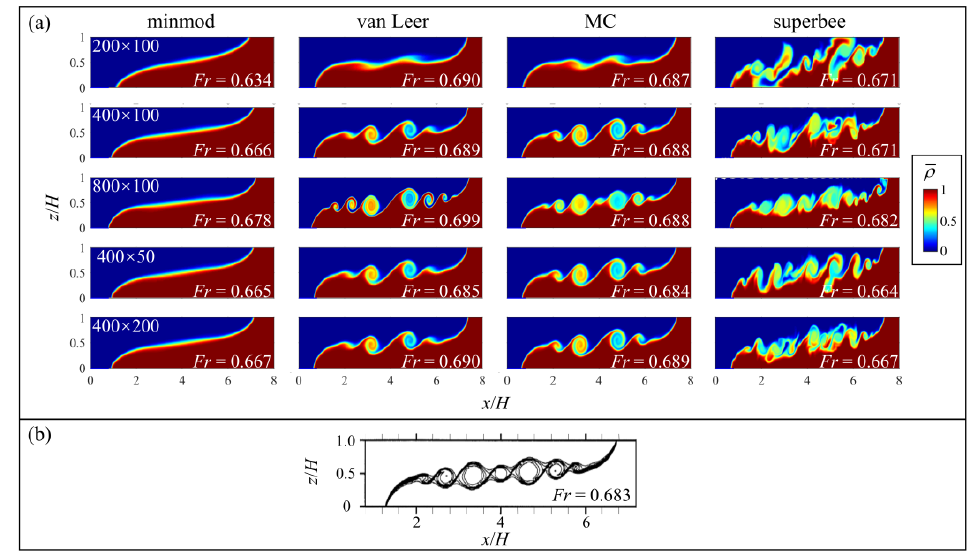
Figure 15. ( a ) Comparison of the simulated density ( ρ = ρ − ρ 1 / ρ 2 − ρ 1 ) distributions for constant viscosity lock-exchange flow simulations with different slope limiters (left to right) and different grid resolutions (top to bottom) at t = 10 T; ( b ) the simulated results by Härtel et al. [42]. The Fr represents the Froude number in that case.